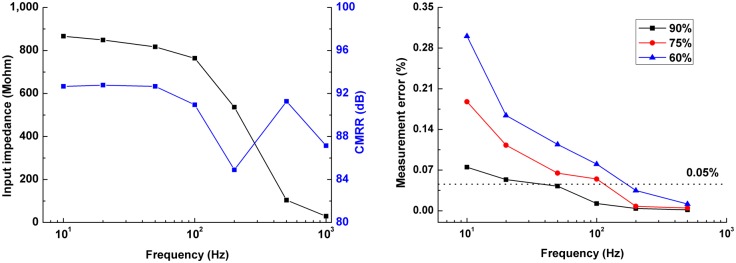
The effects of contact impedance on the boundary voltages because of imbalance between contact impedances.